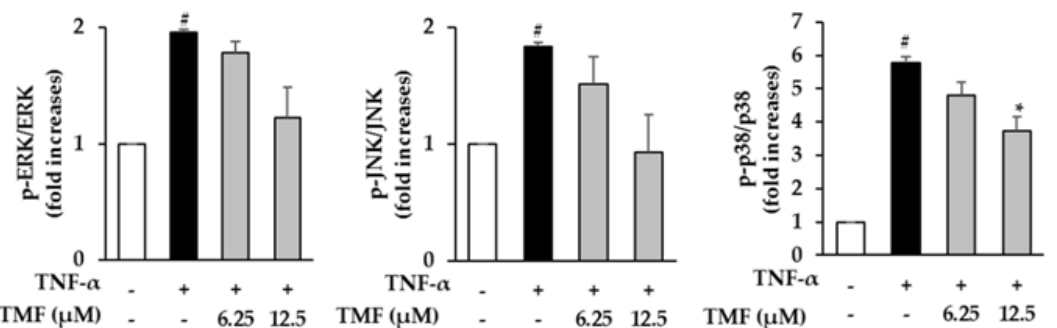
Figure 9. Effect of TMF on the phosphorylation of MAPKs in TNF- α -stimulated HDFs. Expression of p-ERK, ERK, p-JNK, JNK, p–p38, p38, and GAPDH was assessed using western blotting. The data are depicted as mean ± SEM ( n = 3). # p < 0.05 compared to non-treated group and * p < 0.05 compared to TNF- α -treated group. Abbreviations: TMF,